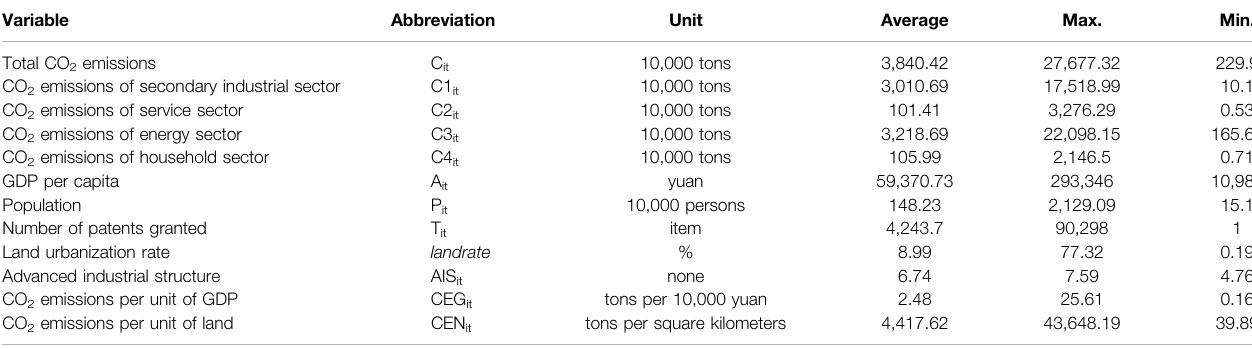
TABLE 1 | Descriptive statistics of each variable.